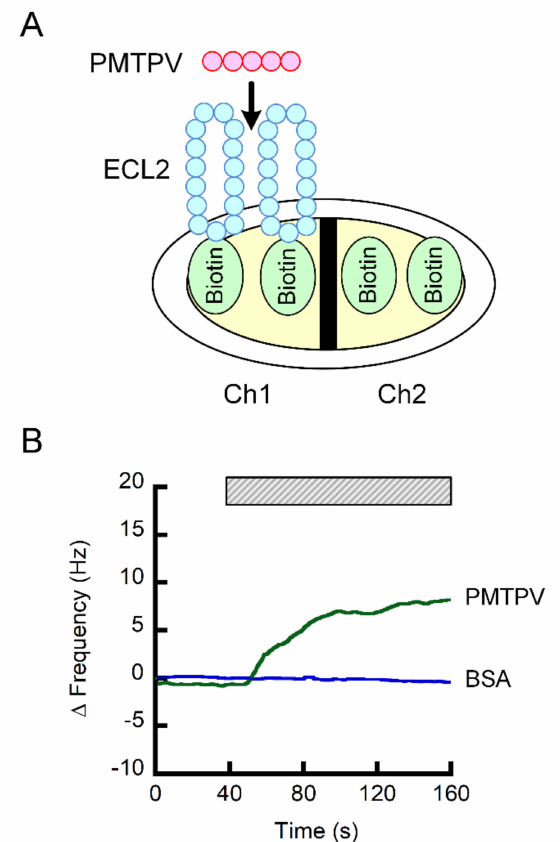
Figure 4. Interaction of PMTPV with ECL2 of CLDN1. ( A ) Scheme for the coating of biotin and biotin-fused ECL2 of CLDN1 on the sensor chip. ( B ) The QCM frequency was measured every 1 s. Then, 5 ng / mL PMTPV was applied at the time period indicated by the hatched box. Bovine serum albumin (BSA) was used as a non-specific protein for a negative